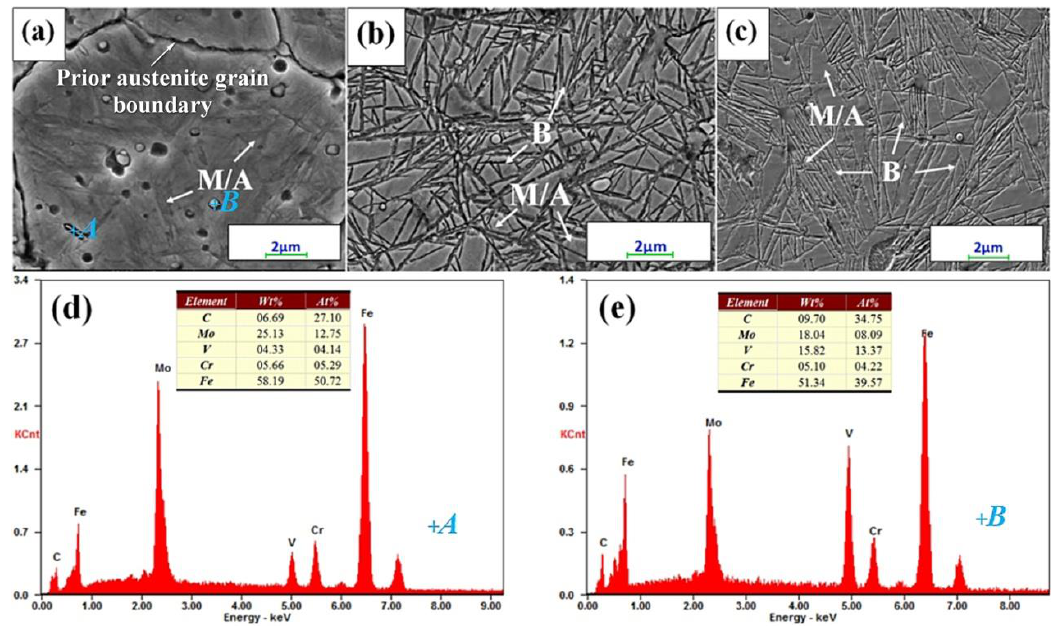
Figure 4. SEM micrographs of as-quenched specimens: ( a ) Q-T process and austempering process ( b ) without and ( c ) with CR; ( d ) and ( e ) EDS spectrum of marked carbides (M / A: Martensite-Austenite islands; B: Lower bainite).